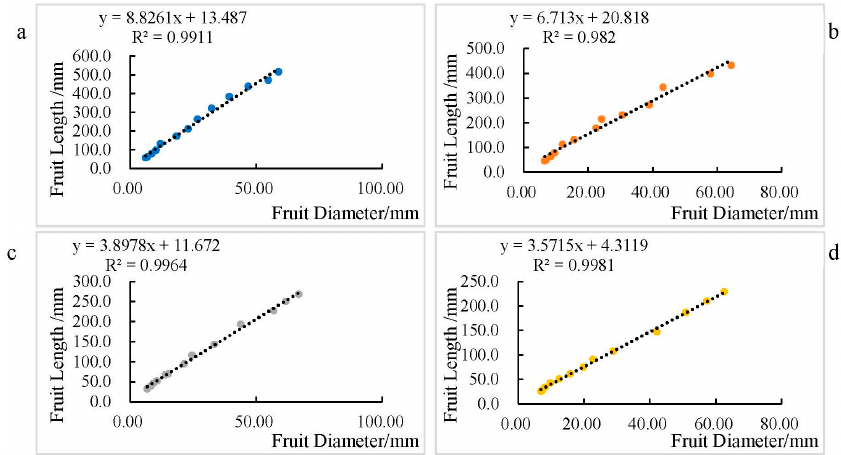
Figure 5. The correlations between fruit length and diameter of long fruit ( a ), medium long fruit ( b ), medium fruit ( c ) and short fruit ( d ).